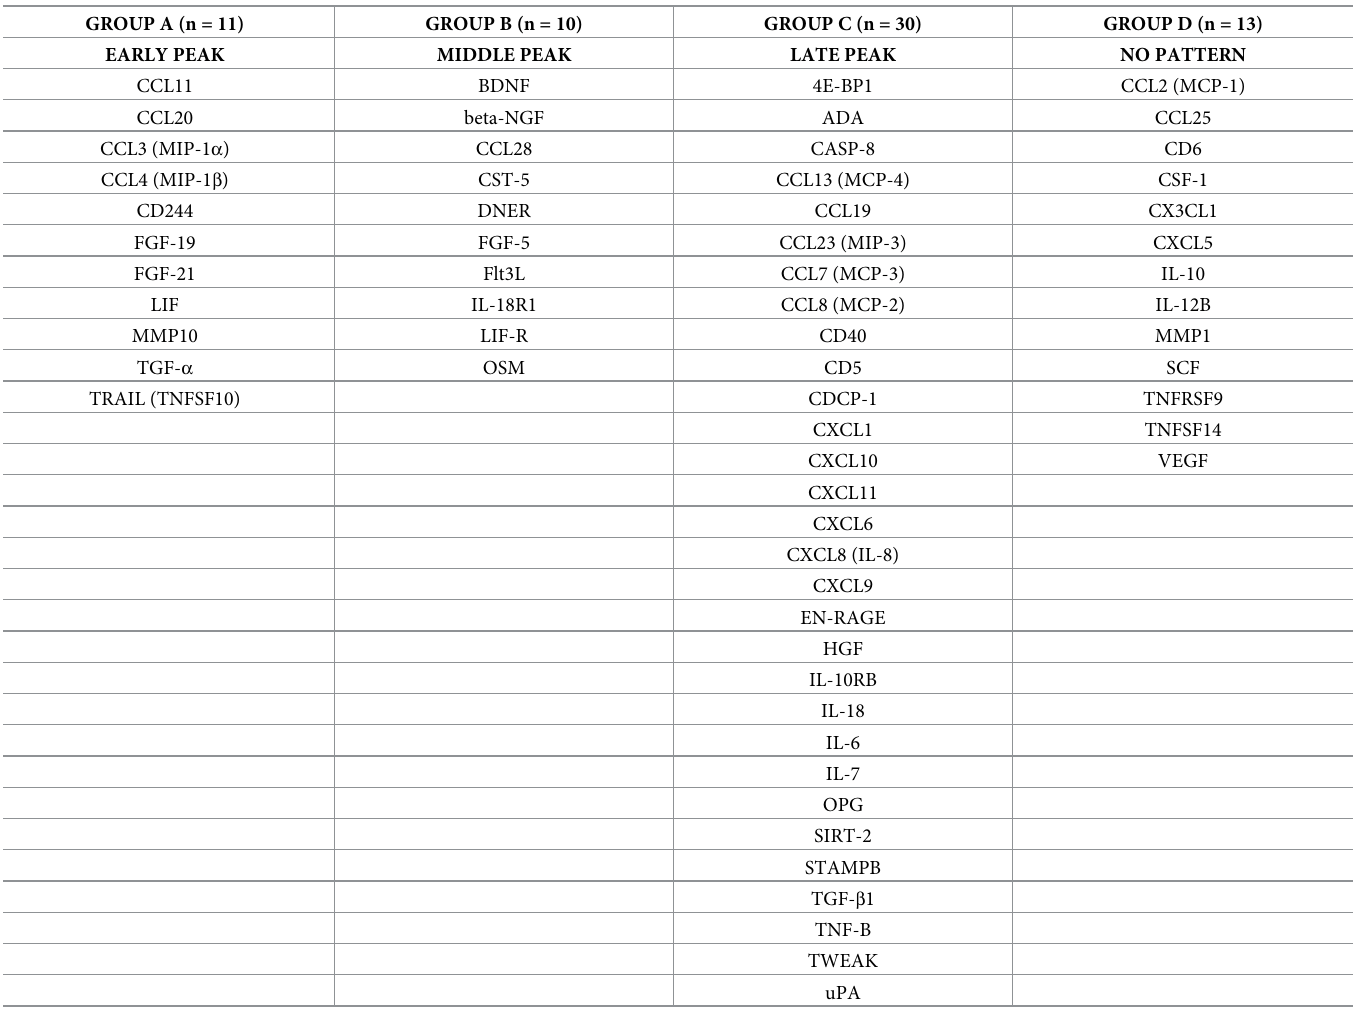
Table 2. Groups of proteins by their temporal pattern of